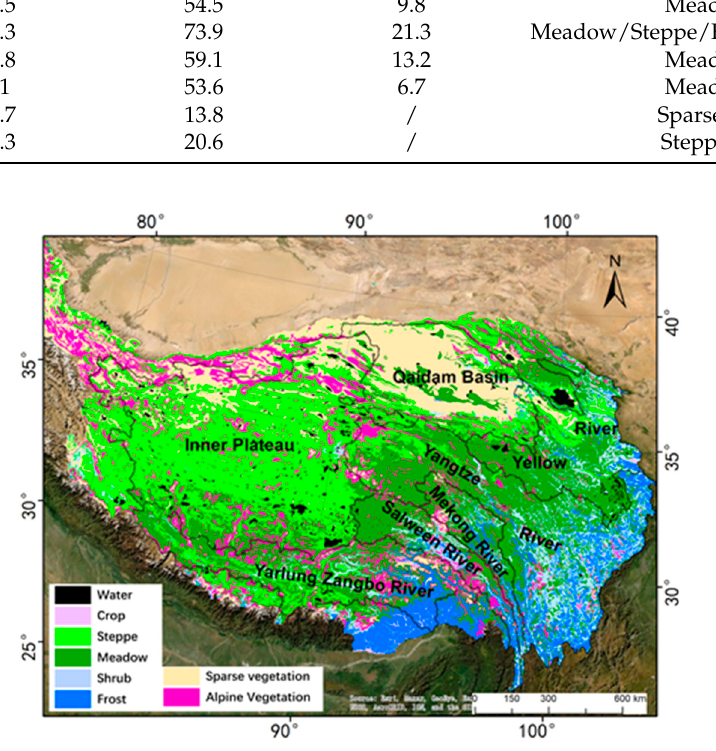
Figure 2. Distribution of vegetation types on the Tibetan Plateau (provided by http://westdc.westgis.ac.cn, accessed date: 01 July 2021).